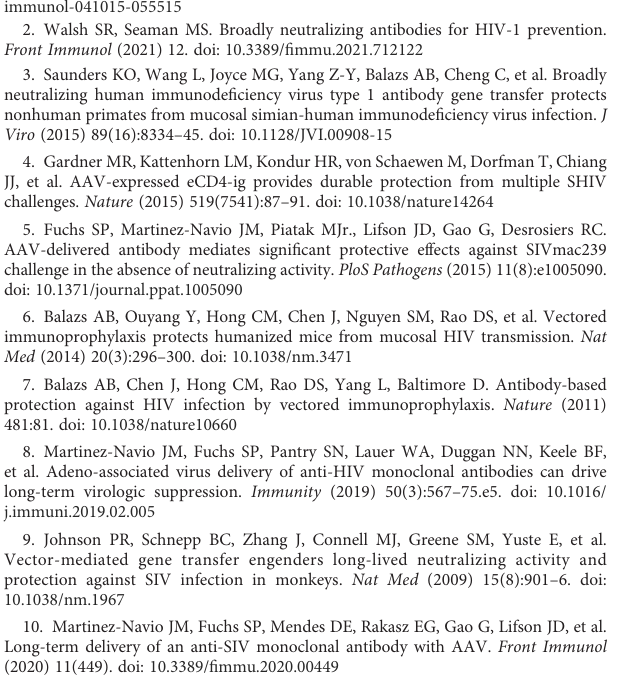
SUPPLEMENTARY FIGURE 1 Quality control analysis of AAV vectors used in capsid study. (A) Representative negative-stained transmission electron micrograph images for each of the AAV vectors used in capsid study. Note two batches of AAV- NP22 and AAV-KP1 were needed to meet the dose requirements for those groups of macaques. (B) Full-empty ratio analysis of the AAV vectors from (A) . Imageswereassessed forfull,empty/broken capsids byIMAGEJ software and reported as a percentage of full capsids. SUPPLEMENTARY FIGURE 2 Correlation analysis of ITS01 concentrations and AAV vector injection volumes. Correlation plots for AUC of ITS01 concentrations and AAV vector injection volumes for each rhesus macaque are plotted. Statistical analysis for correlation shows the data have no correlation. Pearson r values, P value (two-tailed), and R 2 values are included. SUPPLEMENTARY FIGURE 3 ITS01 concentrations and ADA for each rhesus macaque during the course of the capsid study. ITS01 concentrations (black) and ADA (red) are graphed for each individual rhesus macaque involved in the capsid study. Capsid groups are labeled for each row. Data are the same that was used in Figures 4,